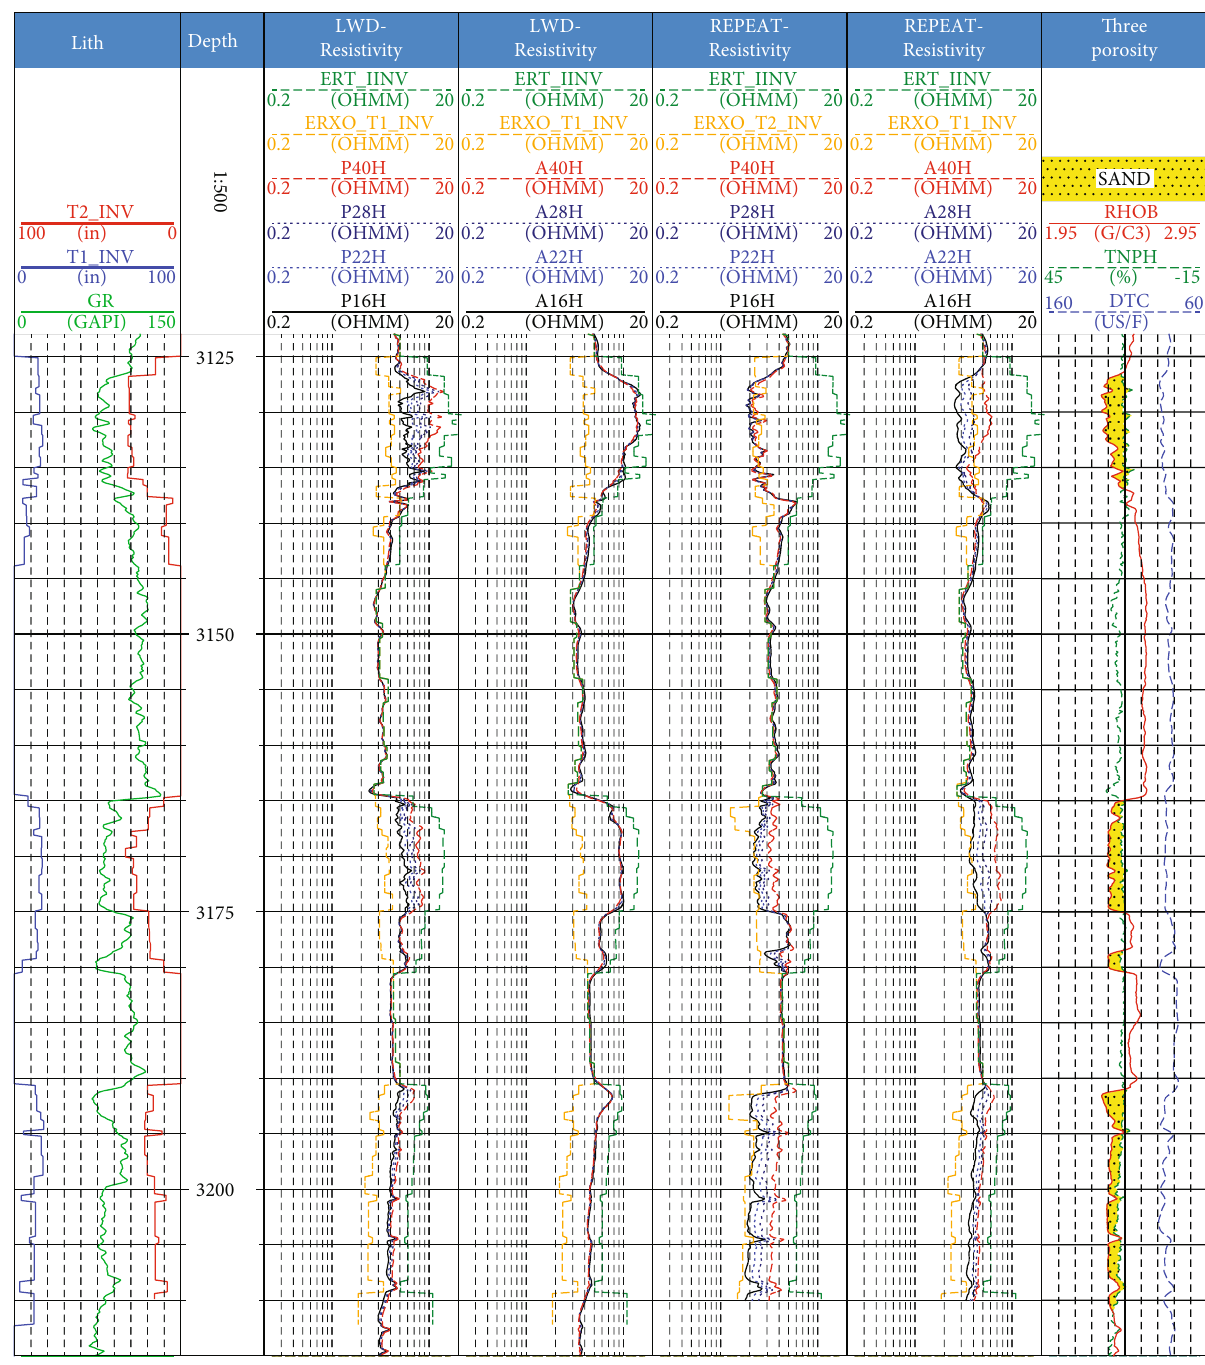
Figure 9: Results of joint inversion of electromagnetic wave resistivity while drilling in well xx at di ff erent